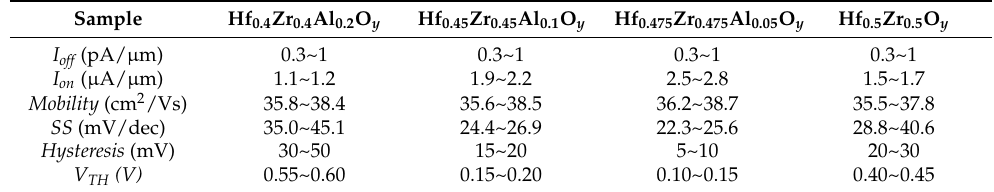
noting that the Hf 0.475 Zr 0.475 Al 0.05 O y NCFET (Al content of 5%) exhibited the lowest SS (22.3 mV/dec) over almost four orders of I d magnitude, the largest I on (2.8 μ A/ μ m) and the small-